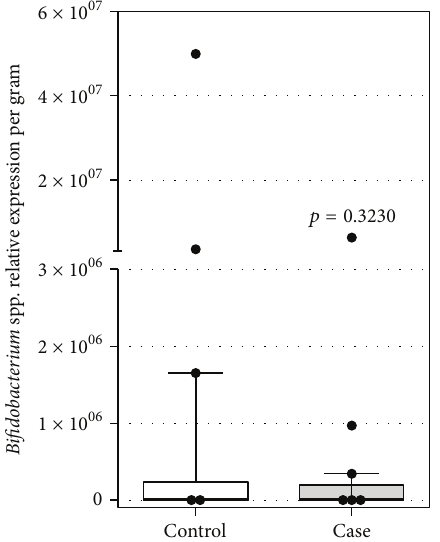
Figure 2: Relative expression of Bifidobacterium spp. analyzed by RT-qPCR in stools of healthy (control) and constipated (case) children ( 𝑛 = 29 for each population) ( Bifidobacterium genus per mg of stool of the two study groups).